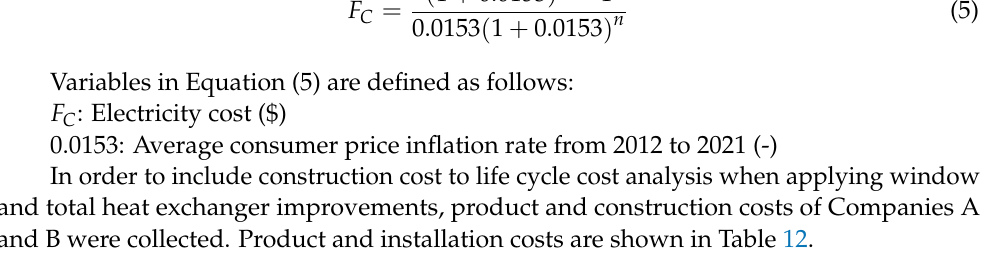
Table 11. Energy cost of district heating energy and electricity for the M complex before and Table 12. Window and total heat exchanger installation and product costs. (Currency: 1$